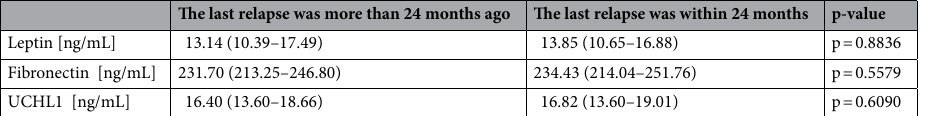
Table 3. Plasma leptin, fibronectin, and UCHL1 concentration depending on the presence of relapse within the last 24 months in MS patients. MS multiple sclerosis. Data is presented as Median with the Percentiles (25-